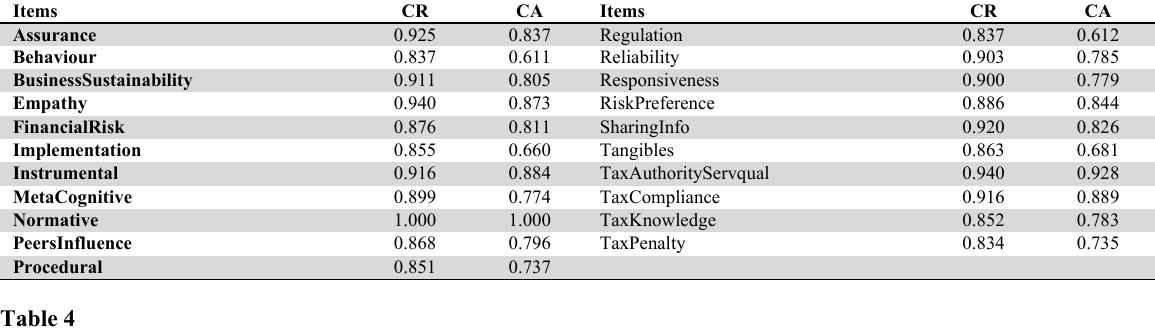
Inner model R square TaxCompliance